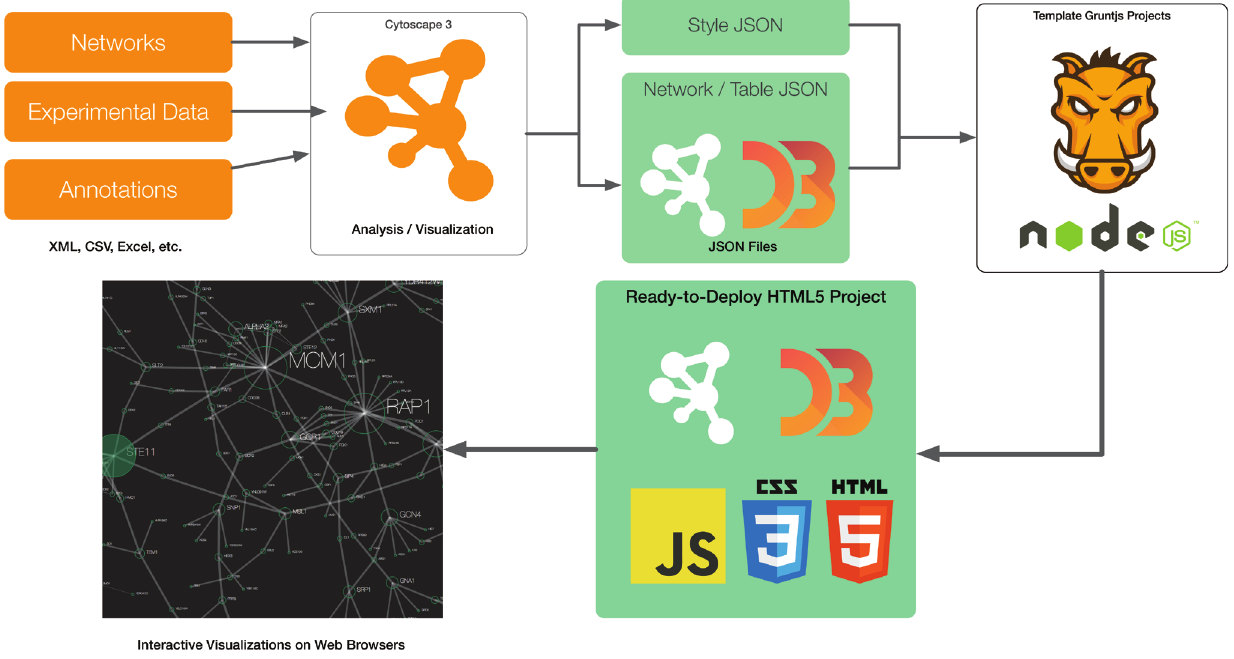
Figure 2. Basic workflow for publishing Cytoscape-generated networks as interactive web visualizations. The combination of Cytoscape 3 and the new JSON exporters can be used as a data integration tool for web-based visualizations. Our sample Grunt project generates a simple template code for visualizing D3.js and Cytoscape.js JSON